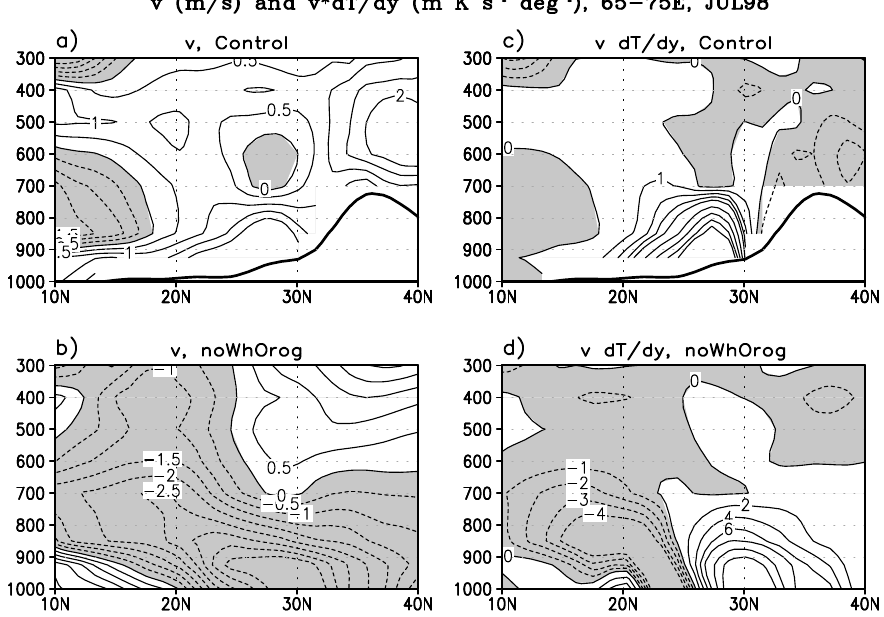
Fig. 12. Vertical profile of meridional velocity from the (a) control and (b) noWhOrog simulations, averaged between 65 ◦ –75 ◦ E. Vertical profiles of temperature (energy) advection from the(c) control and (d) noWhOrog simulations are shown for the same region.